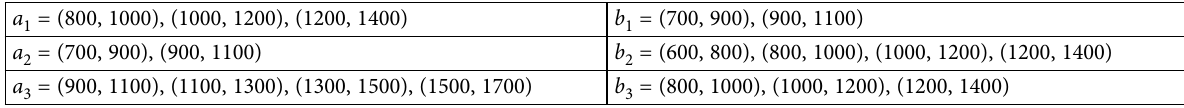
Table 7. Summarises the value of demand and supply with interval type multi-choice